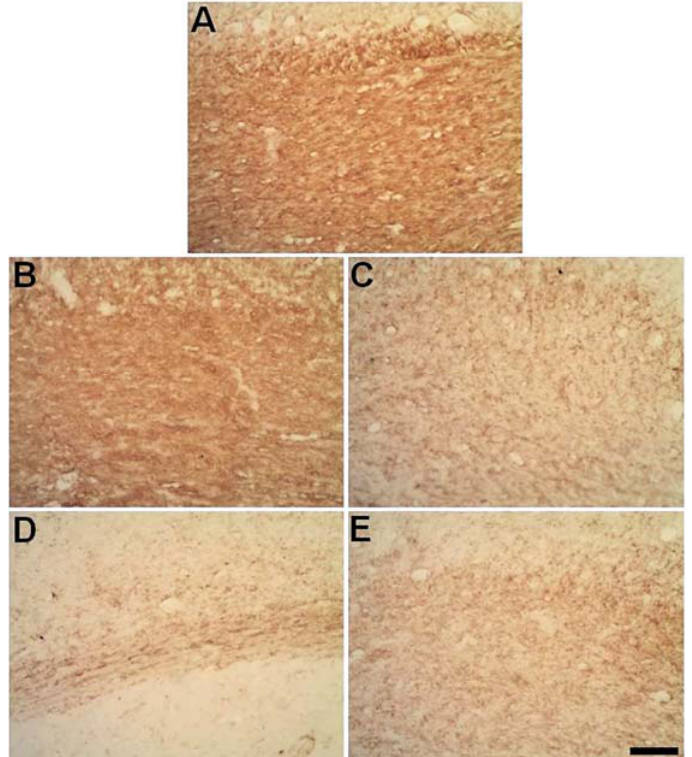
Figure 7. Myelin impairment in the CC secondary to focal striatal ischemia, as revealed by anti-MBP immunohistochemistry. Control animal injected with sterile saline ( A ) and ischemic animals injected with ET-1 at 3 ( B ); 7 ( C ); 14 ( D ); and 30 ( E ) PLDs. Decreased MBP immunoreactivity was present in later survival times. Scale bar: 100 μ m.